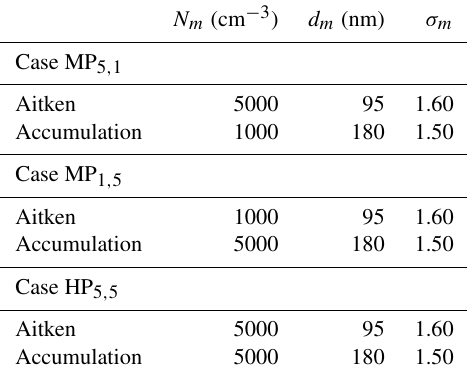
Table 1. Parameters for the Aitken and accumulation lognormal number size distribution for the defined case